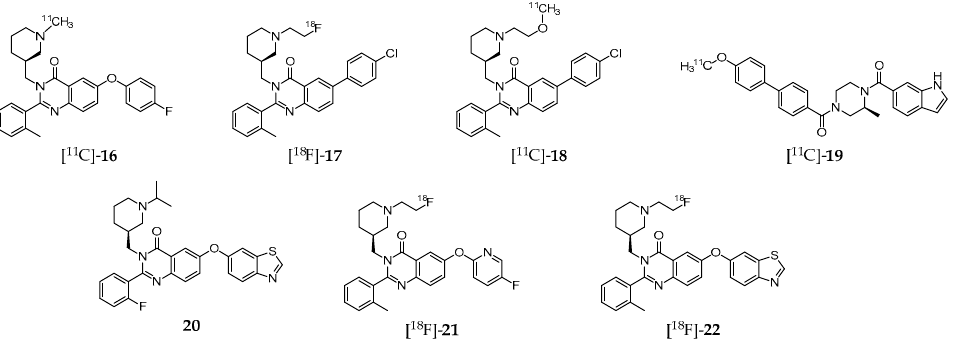
Figure 3. Growth hormone secretagogue receptor (GHSR-1a) specific quinazoline derivatives.